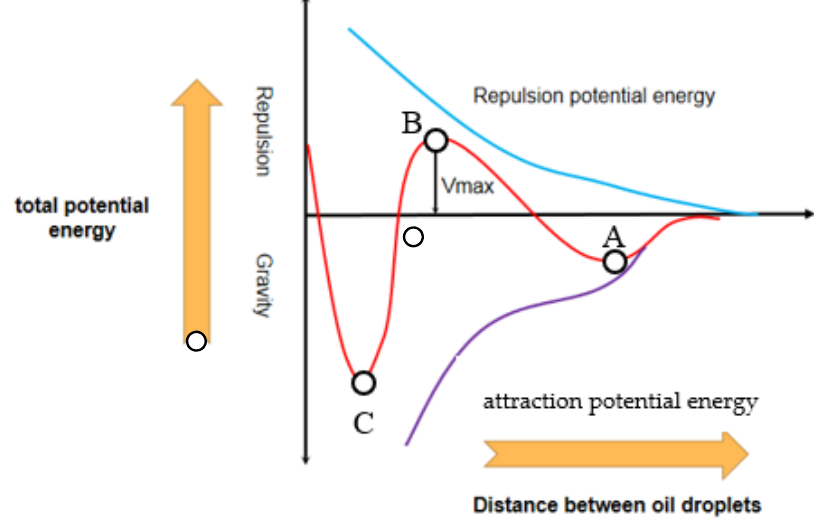
Figure 6. Curves of gravitation, repulsion, and total potential energy.